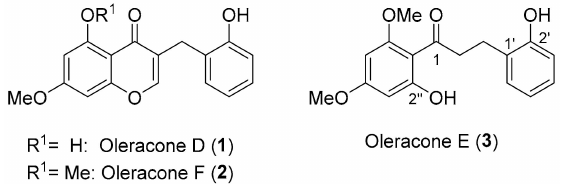
Figure 1. The structures of oleracones D ( 1 ), F ( 2 ), and E ( 3